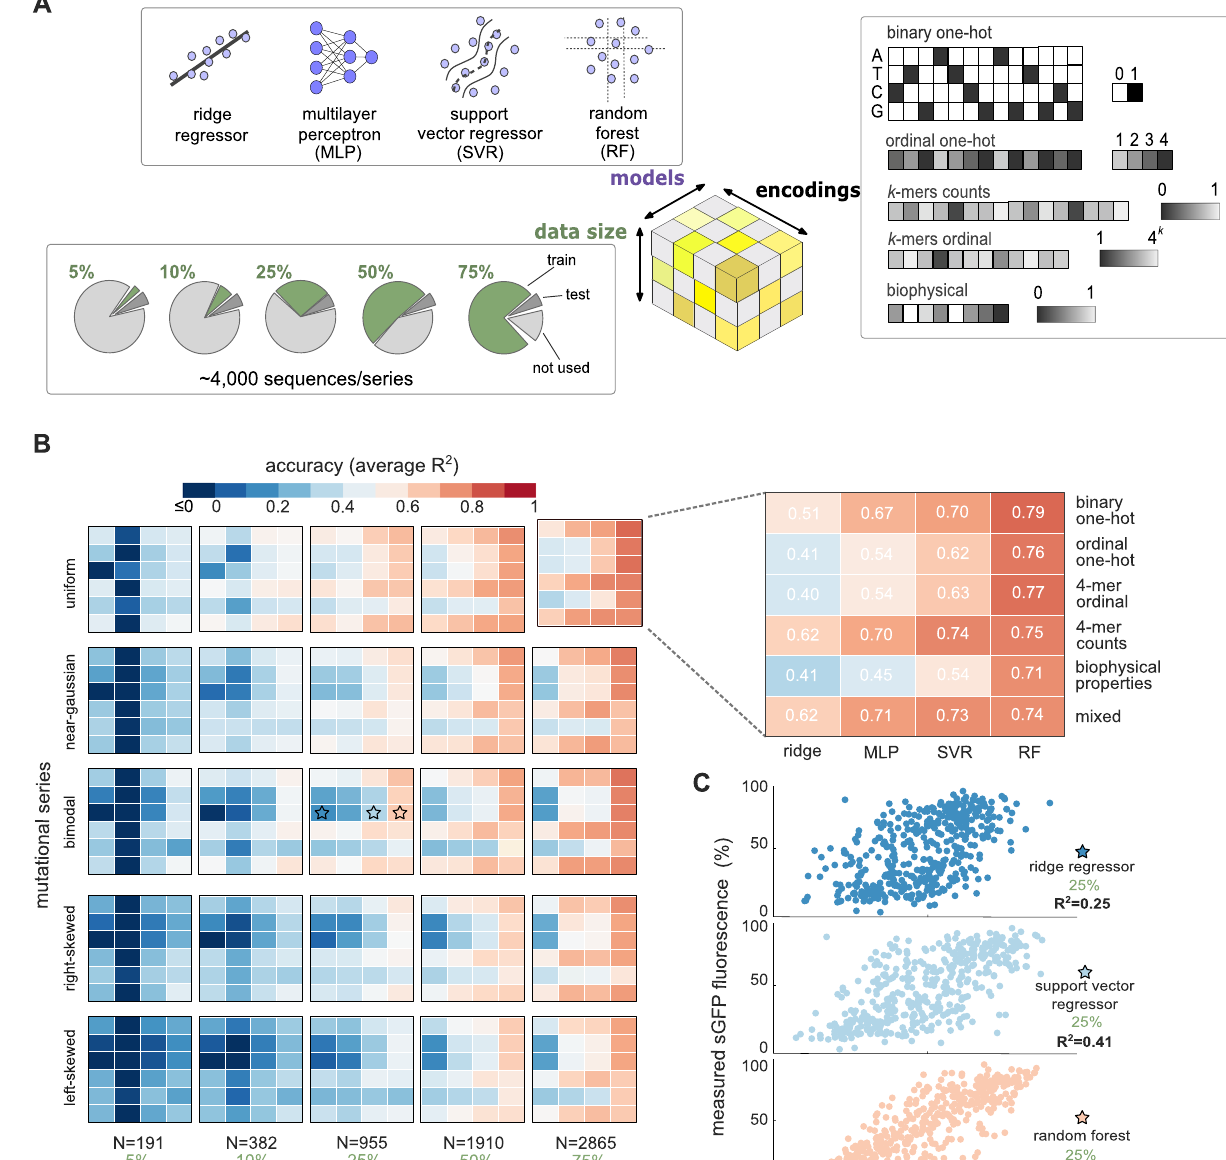
Fig. 2 | Accuracy of non-deep machine learning models. A We trained models using datasets of variable size and with different strategies for DNA encoding. Sequences wereconvertedto numericalvectors with fi ve DNA encoding strategies (Table 1), plus an additional mixed encoding consisting of binary one-hot aug- mented with the biophysical properties of Fig. 1A; in all cases, one-hot encoded matriceswere fl attenedasvectorsofdimension384.Weconsideredfournon-deep models trained on an increasing number of sequences from fi ve mutational series with different phenotype distributions (Fig. 1B). B Impact of DNA encoding and data size on model accuracy. Overall we found that random forest regressors and binary one-hot encodings provide the best accuracy; we validated this optimal choice across the whole sequence space by training more than 5000 models in all mutational series (Supplementary Fig. S5). Phenotype distributions have a minor impact on model accuracy thanks to the use of strati fi ed sampling for training.